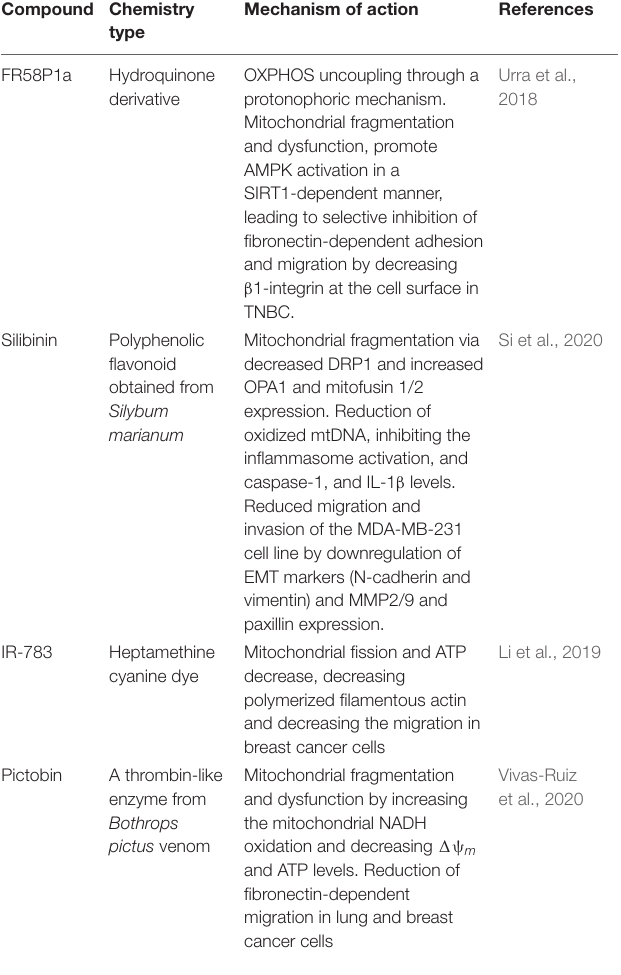
TABLE 1 | Mitochondria-affecting compounds with migrastatic effect. Compound Chemistry